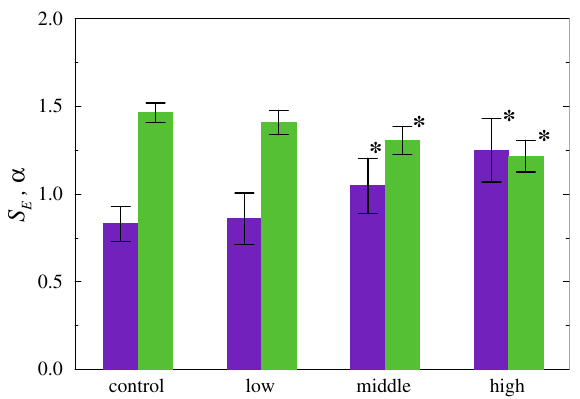
Fig. 5. Statistical analysis of the complexity measure SampEn ( S E , violet) and the scaling exponent of the DFA-approach ( (cid:3) , green) at the transition from the control state to a late stage of gastric tumor. Both approaches provide identi¯cation of the precancer stage ( p < 0.05 compared to control